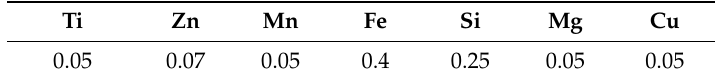
Table 2. Chemical composition of the AA1050 aluminum alloy [wt.%] [23].